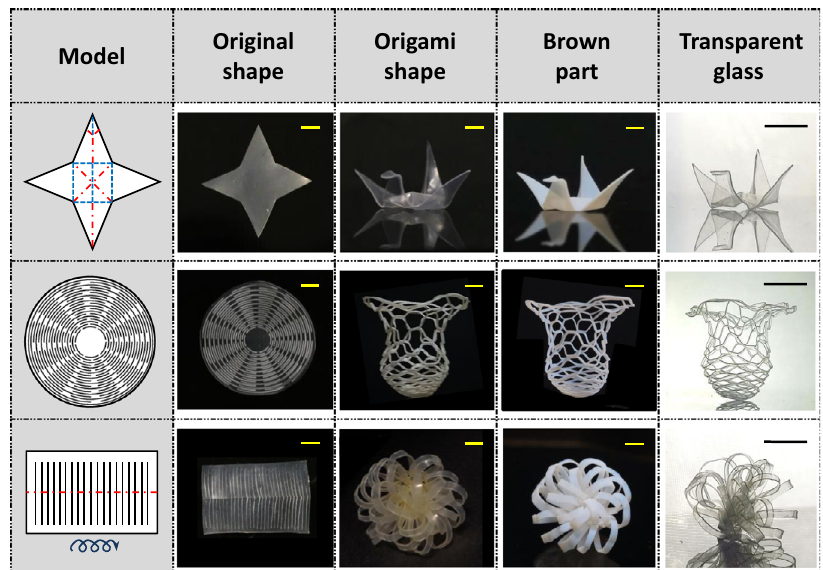
Fig. 4 Fabrication of transparent origami glass. In the models, the black lines, the red dashed lines, and the blue dashed lines represent cutting, mountain folding, and valley folding, respectively. The blue twisting arrow represents curling. All scale bars: 1